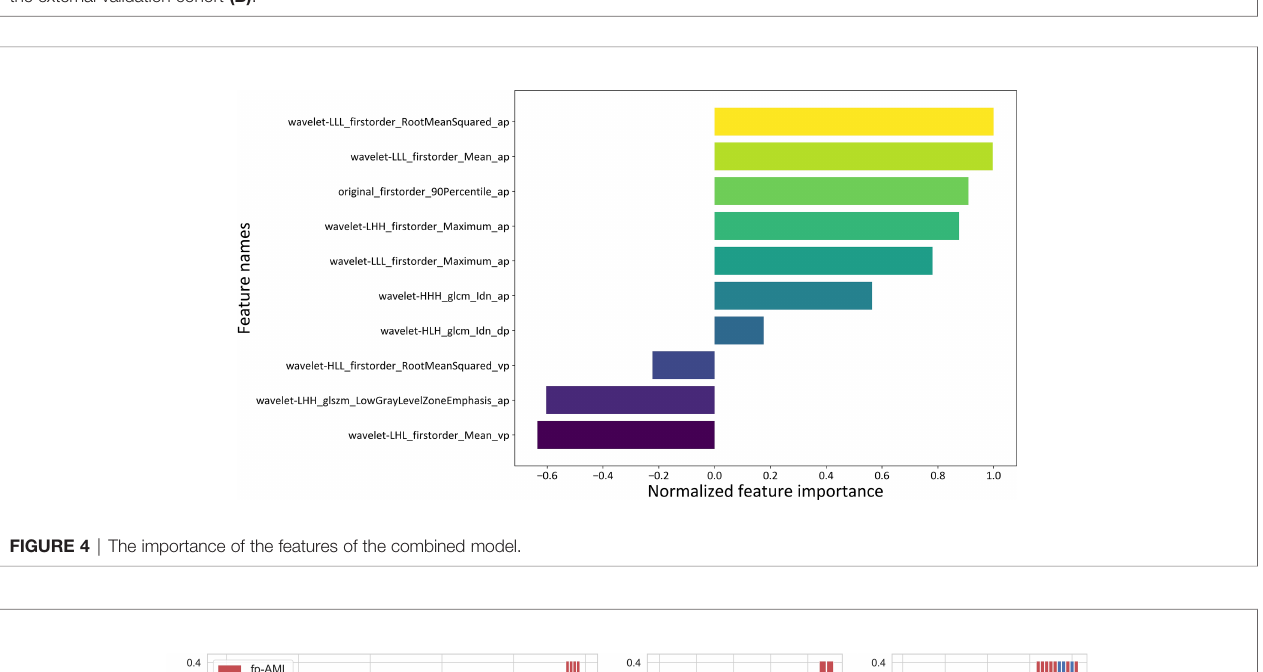
FIGURE 3 | The receiver operating characteristic curves of the four models and the performance of the two radiologists on the internal validation cohort (A) and on the external validation cohort (B)